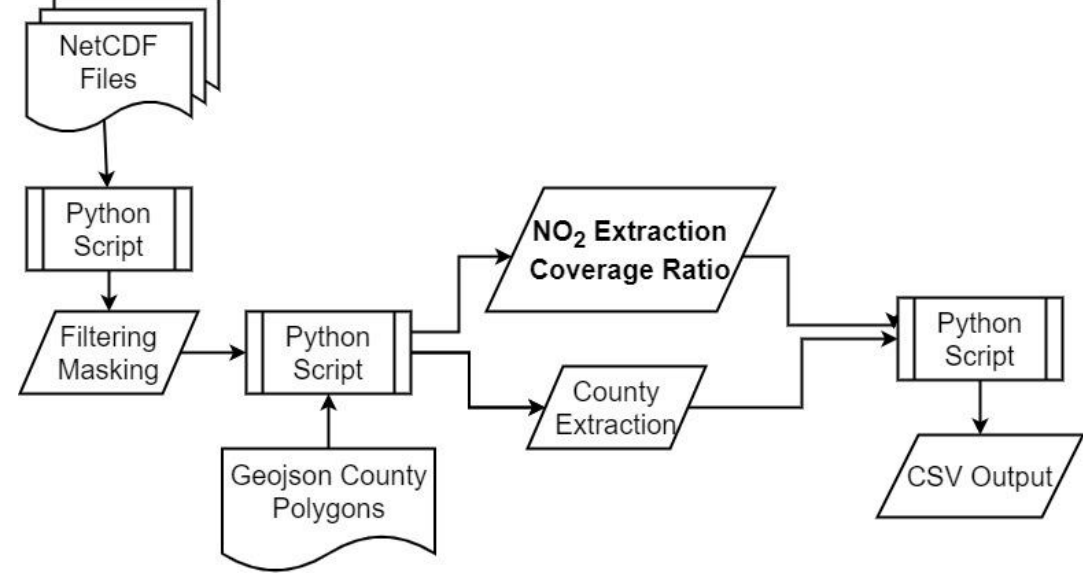
Figure 2. Flowchart for extracting daily NO 2 concentration for each county in Florida.